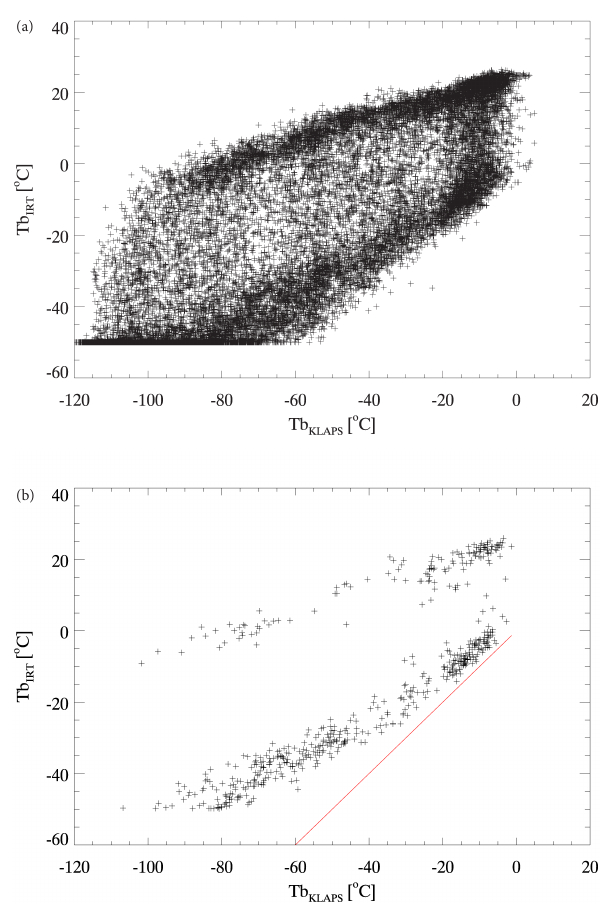
Figure 6. The relationship between the simulated clear-sky Tb (Tb KLAPS ) and the measured Tb IRT for all conditions for one year (a) , and selected cases with the Tb IRT values having a small tempo- ral variation (b) , representing overcast and clear-sky conditions (see text for details). The red line represents the one-to-one line.